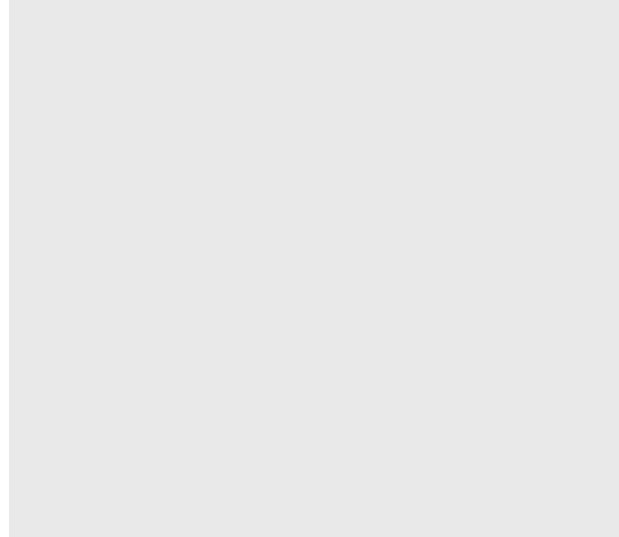
TABLE III - Estimated dietary exposure for AFB